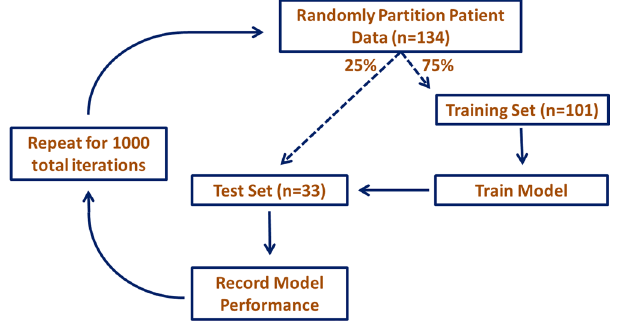
Figure 2. Illustration of the iterative toxicity prediction model construction process using repeated cross-